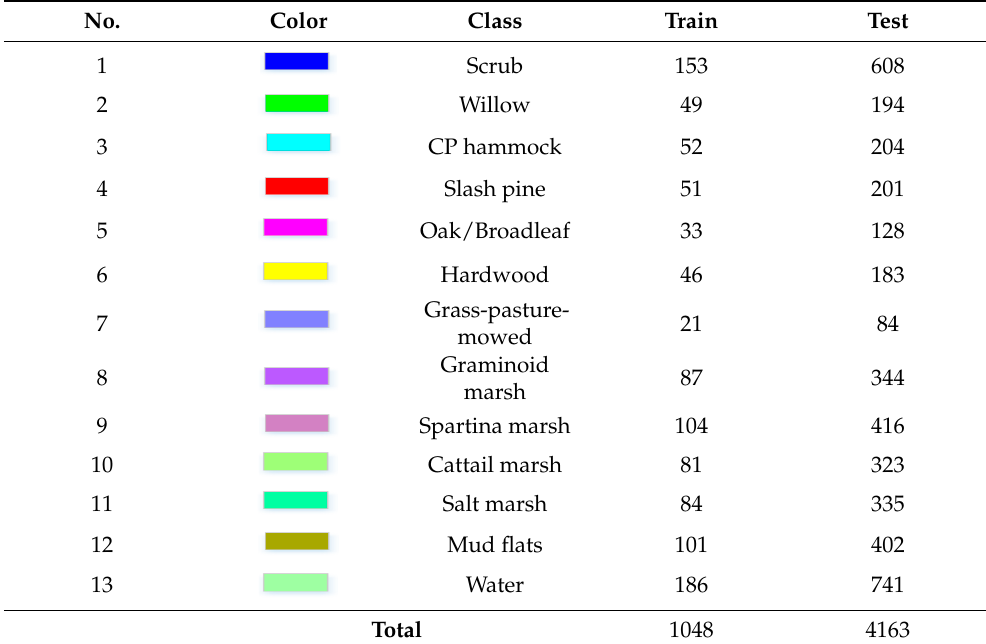
Table 3. Number of training and test samples of IP dataset. No.